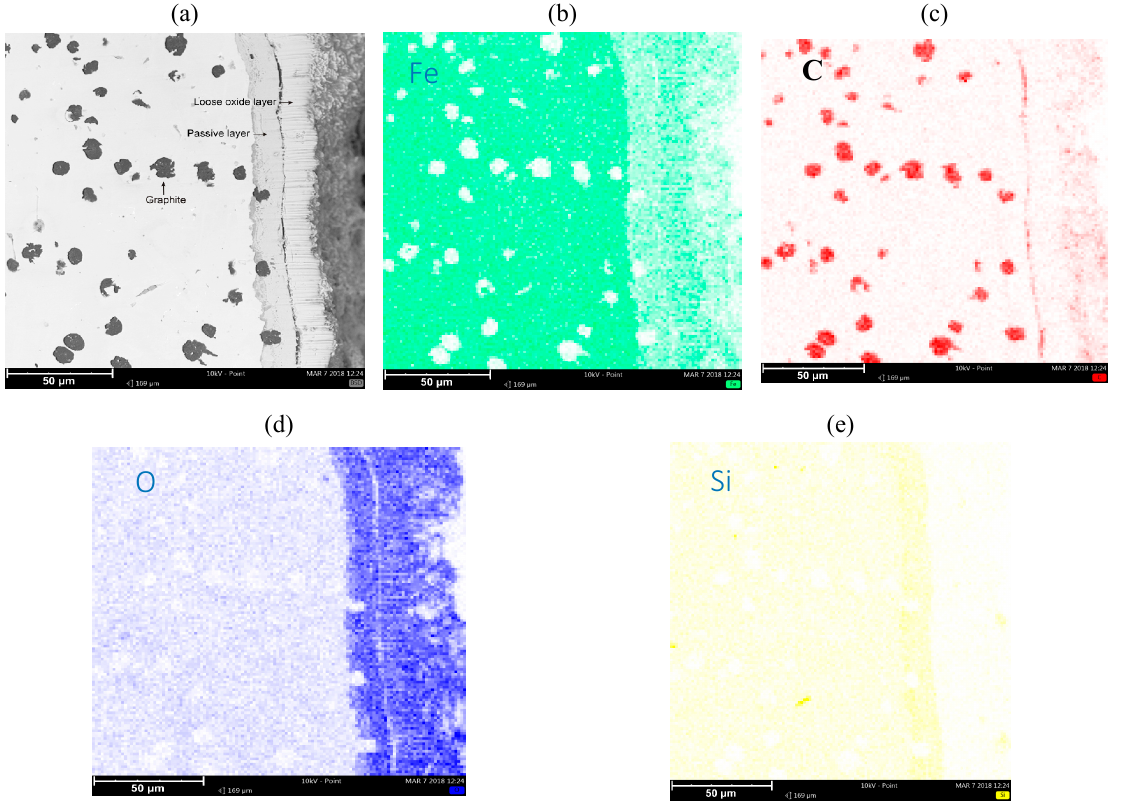
Figure 3. Microstructure of SiMo cast iron, 0.01% Mo ( a ). Elements decomposition maps. Map for ( b ) Fe, ( c ) C, ( d ) O, and ( e ) Si.